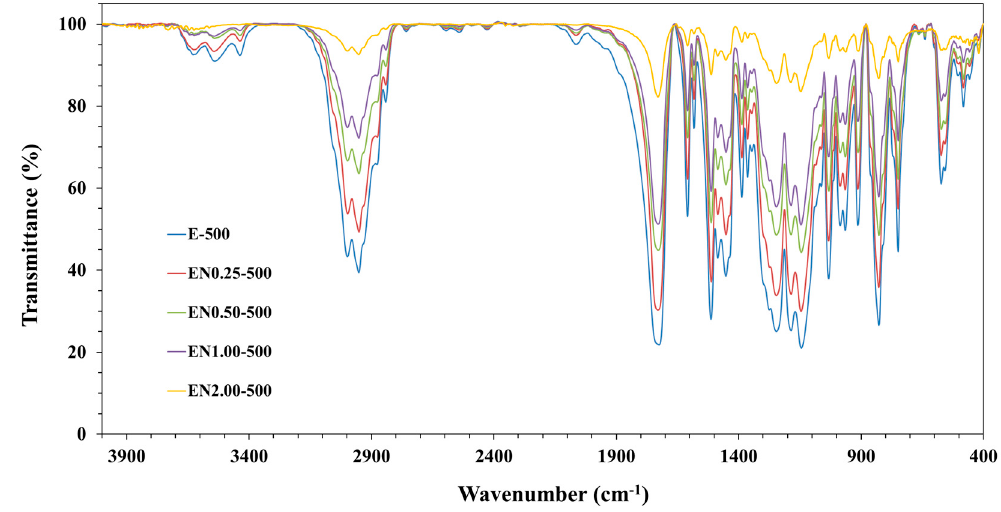
Figure 3. FTIR spectra of microcapsules prepared with different CNT contents.